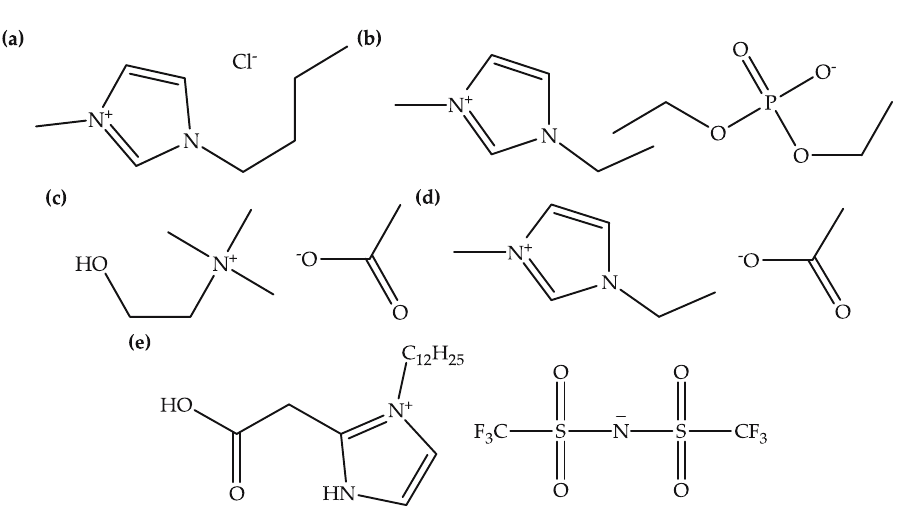
Figure 2: Chemical structures of ( a ) BmimCl, ( b ) EmimDep, ( c ) ChOAc, ( d ) EmimOAc, and ( e ) CmdimNTf 2